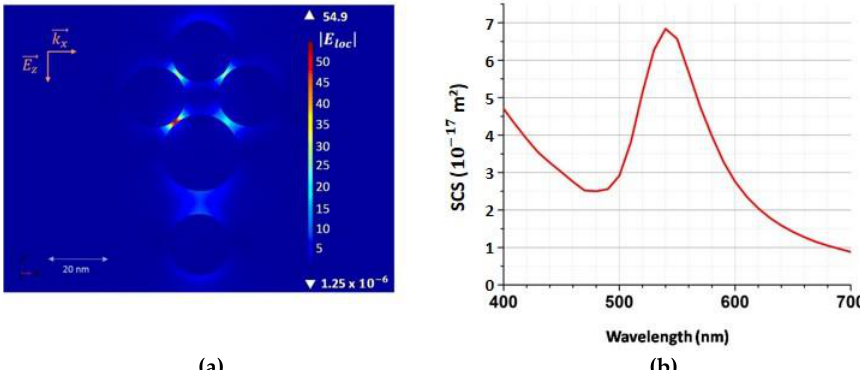
Figure 7. ( a ) Near-field mapping around the gold structure. ( b ) The plasmonic structure Scattering Cross Section (SCS)